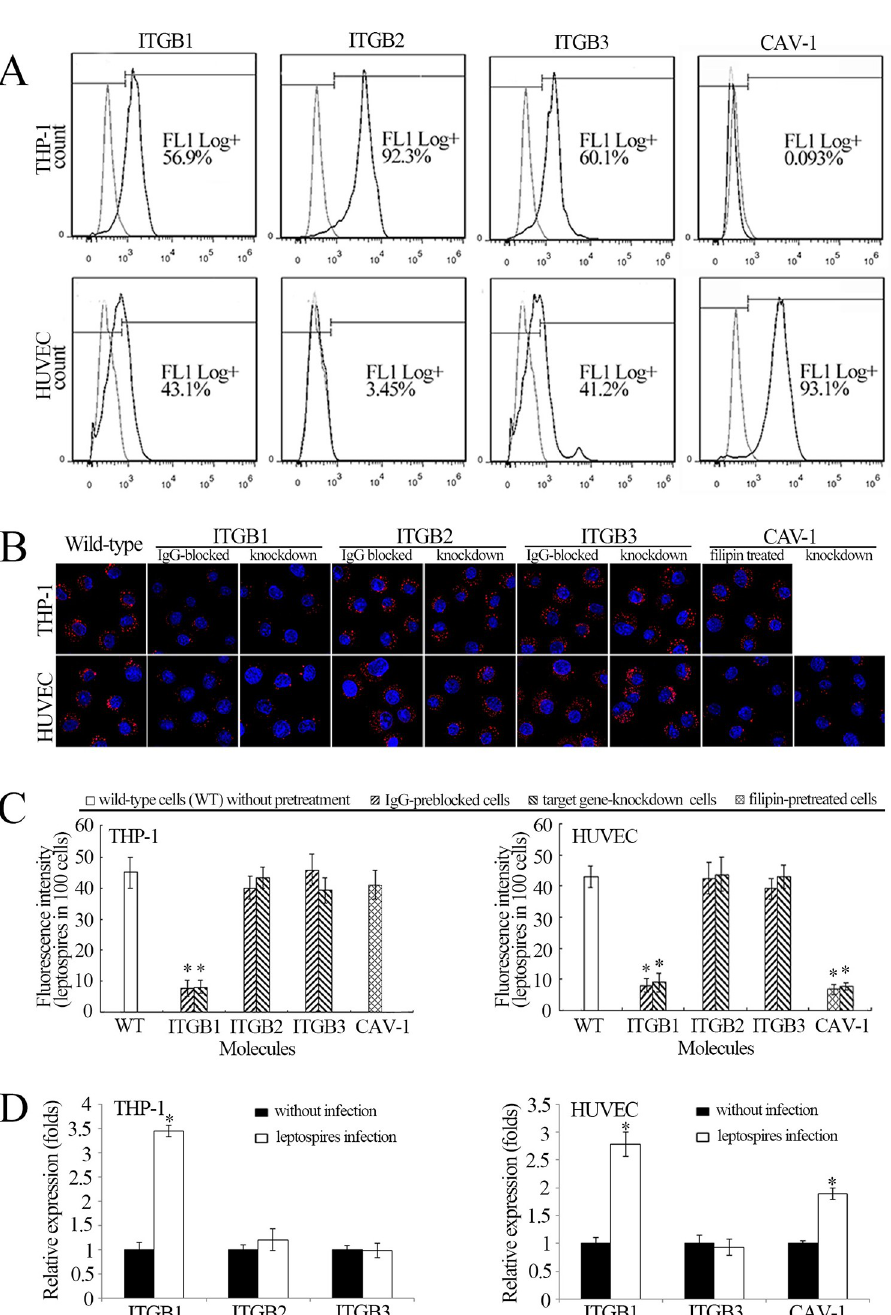
Fig 3. ITGB1 in THP-1 and CAV-1 in HUVEC responsible for internalization of leptospires. A: Distribution of ITGB1, ITGB2, ITGB3 and CAV-1 in THP-1 and HUVEC determined by flow cytometry. Ten thousand cells were analyzed for each of the specimens; B: Leptospires in THP-1 and HUVEC under the laser confocal microscope after infection with L . interrogans strain Lai for 1 h. The blue plaques in the middle of cells indicate the nuclus. The red spots around the nuclus indicate the intracellular leptospires; C: Statistical summary of red fluorescence intensity reflecting the leptospires in THP-1 and HUVEC after infection with L . interrogans strain Lai for 1 h. Statistical data from experiments such as shown in B. Bars show the means ± SD of three independent experiments. One hundred cells were analyzed for each of the specimens. � : p < 0.05 vs the red fluorescence intensity reflecting the leptospires in the wild type cells during infection. D: Relative gene expression of ITGB1, ITGB2 ITGB3, CAV-1 in THP-1 or HUVEC were analysed by comparing treatment of 4h of leptospires infection and non-infection. Bars show the means ± SD of three independent experiments. � : p < 0.05 vs the gene relative expression of treatment of non-infection.